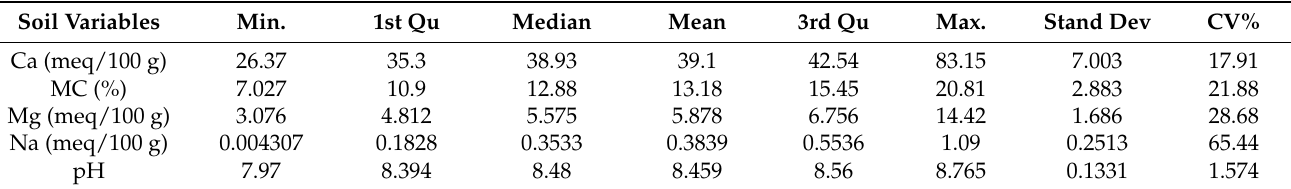
Table 2. Statistical summary of validation soil sample dataset.